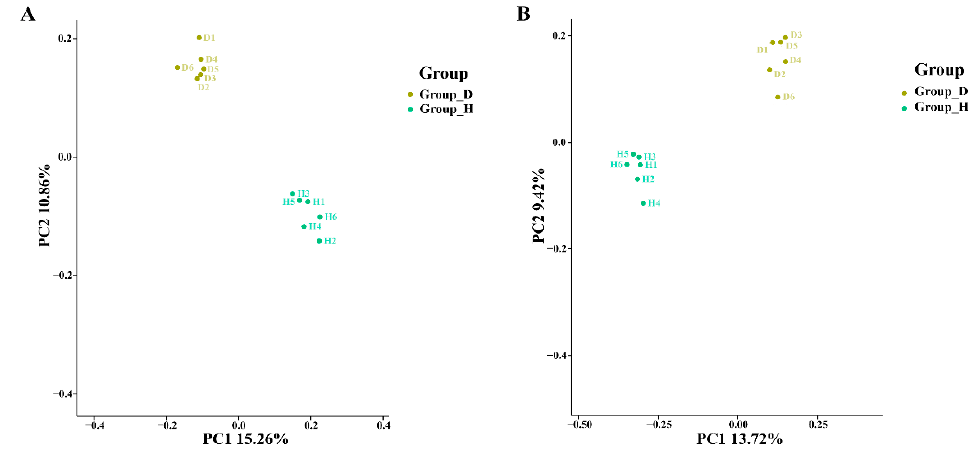
Figure 2. PCoA results from soil bacteria ( A ) and fungi ( B ) based on OTU abundance. H and D represent healthy tree and diseased trees, respectively.